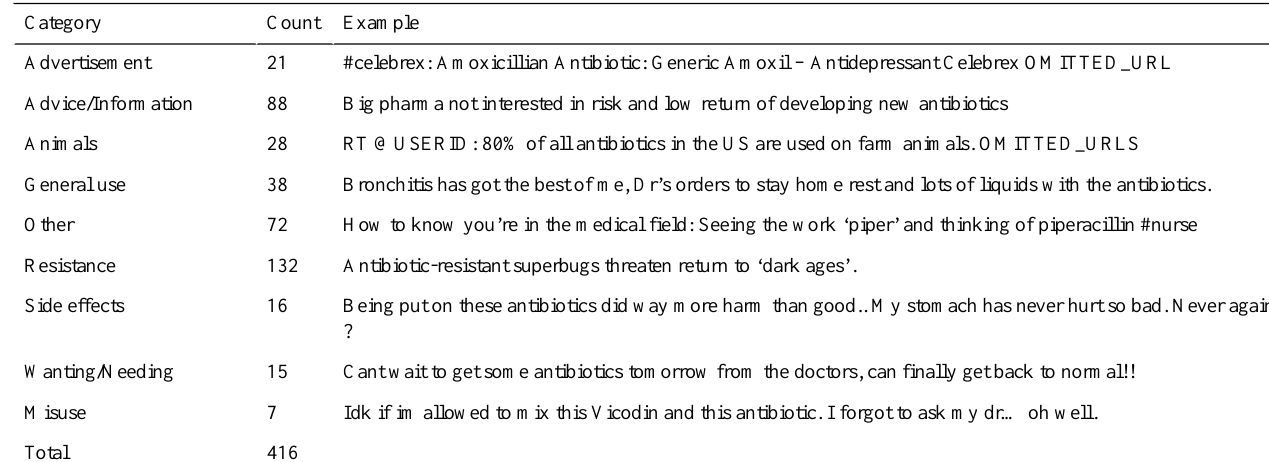
Table 1. Categories considered for antibiotic-related tweets, quantities of each in the labeled dataset, and examples.